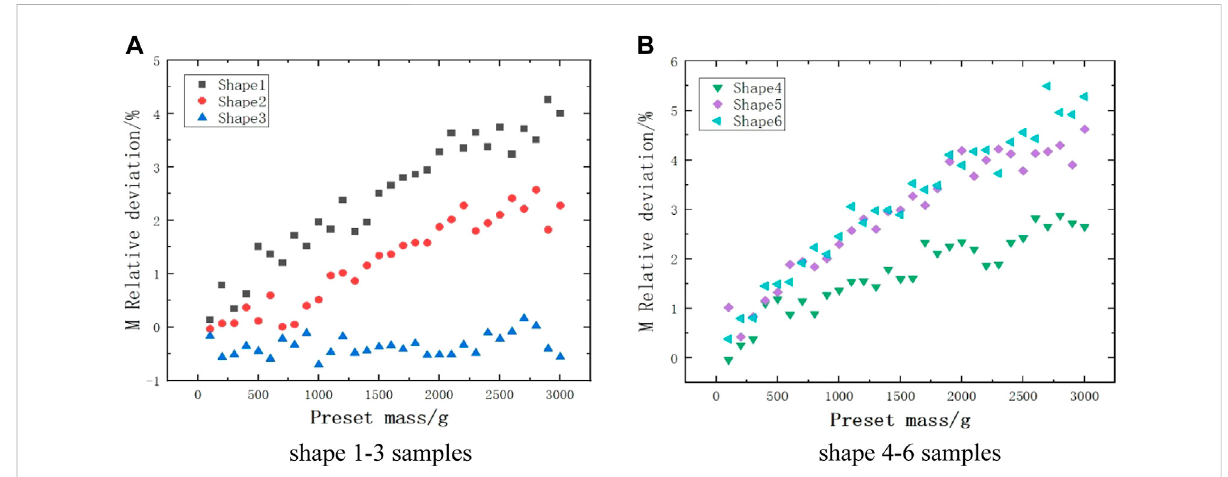
FIGURE 6 Relative error of neutron multiplication with mass for different shapes. (A) Shape 1-3 samples. (B) Shape 4-6 samples.